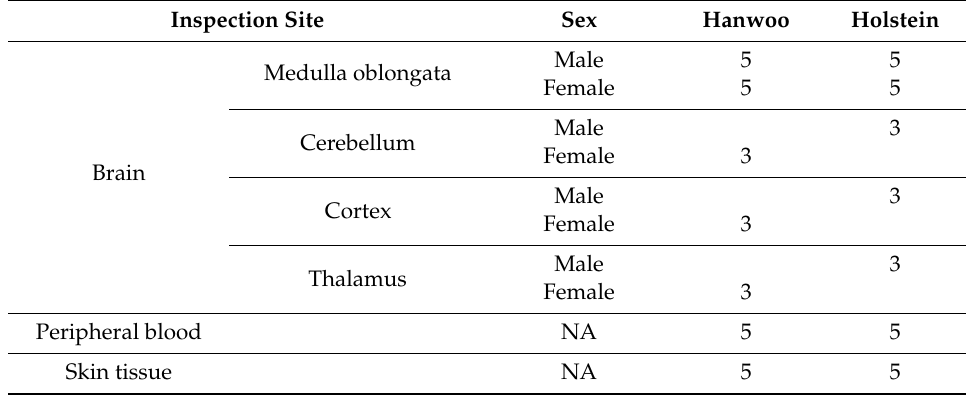
Table 1. DNA extraction was performed with peripheral blood and brain tissues, and all DNA samples were subjected to quality checks using the A260 / A280 ratio with 1.8–2.0 values. Table 1. Detailed information of the bovine samples